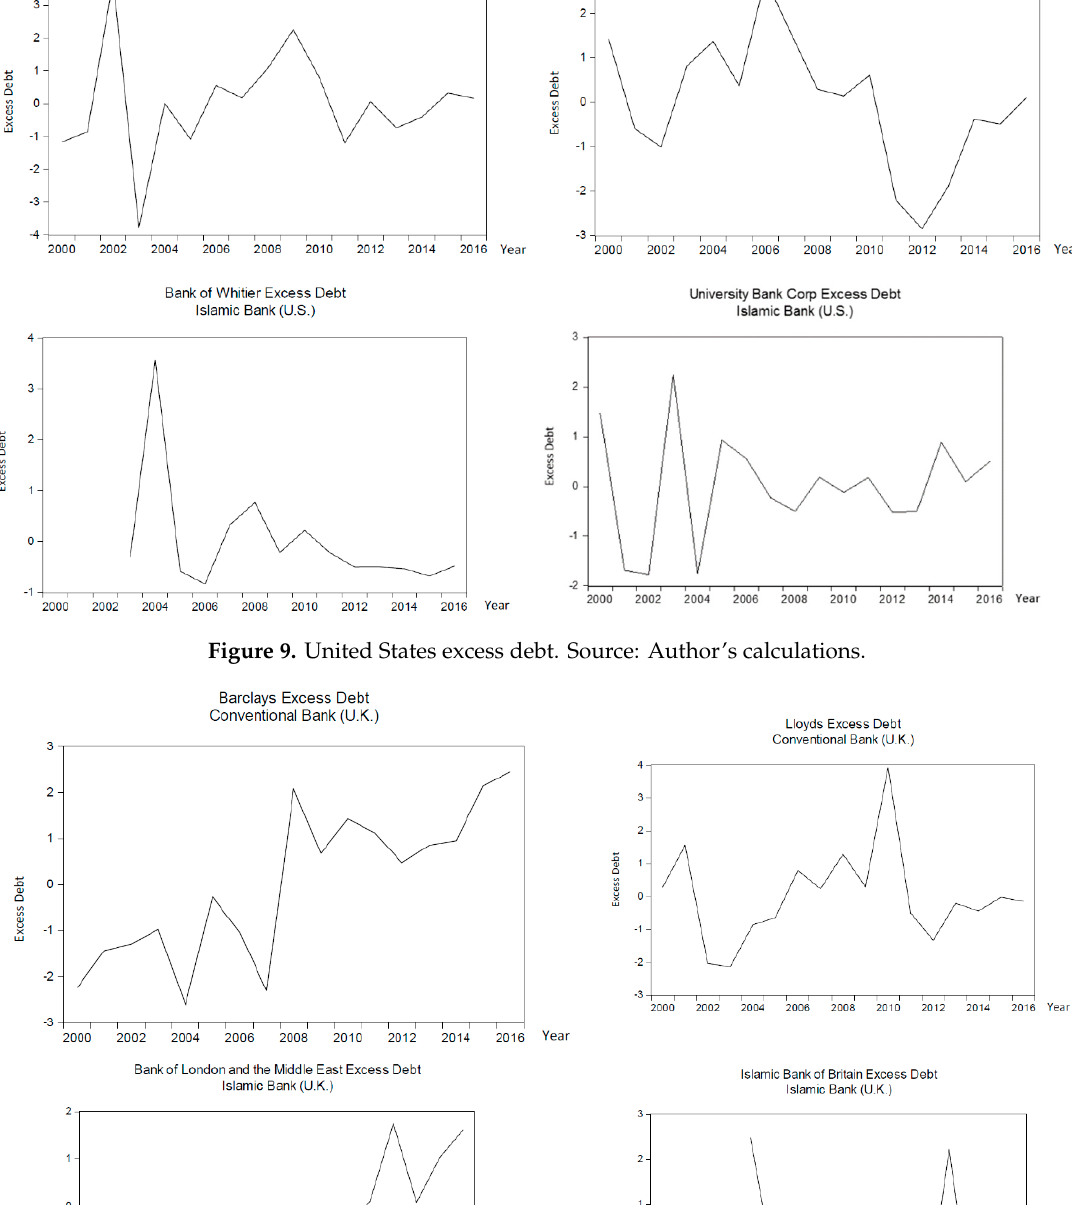
Figure 8. Malaysia excess debt. Source: Author’s calculations.